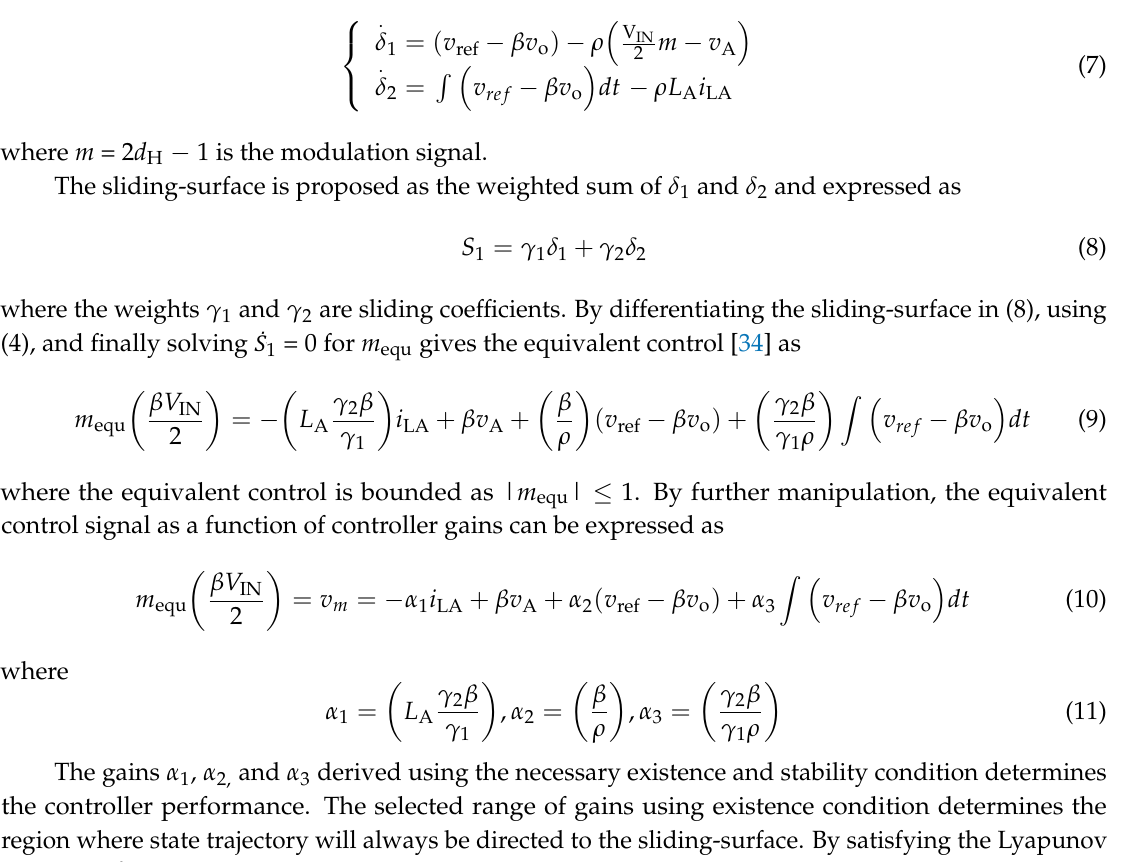
Table 1. Parameters of GaN class-D amplifier with fourth-order filter.